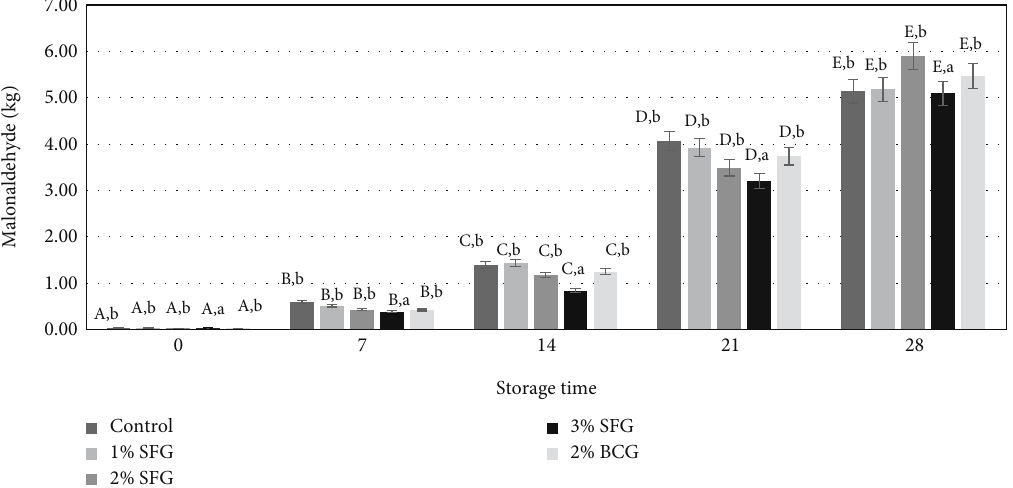
Figure 5: Addition of level gelatin (%) and storage time (days) on TBA reactivity (mg/kg malonaldehyde) sausage. Di ff erent uppercase letters indicate di ff erences in storage time ( p < 0 : 05 ), and lowercase letters indicate di ff erences with level gelatin ( p < 0 : 05